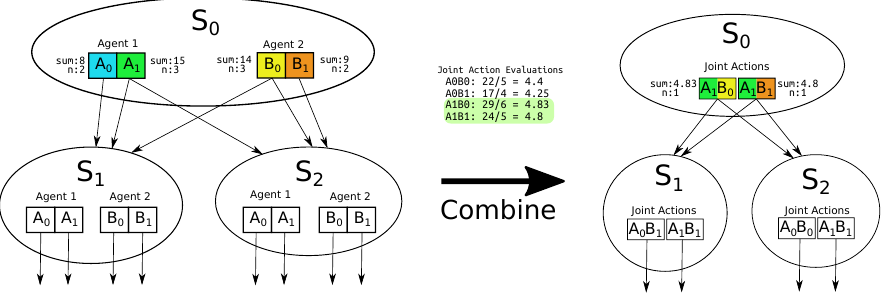
Figure 5. Combining single agent actions of decoupled-MCTS to create a search tree with joint